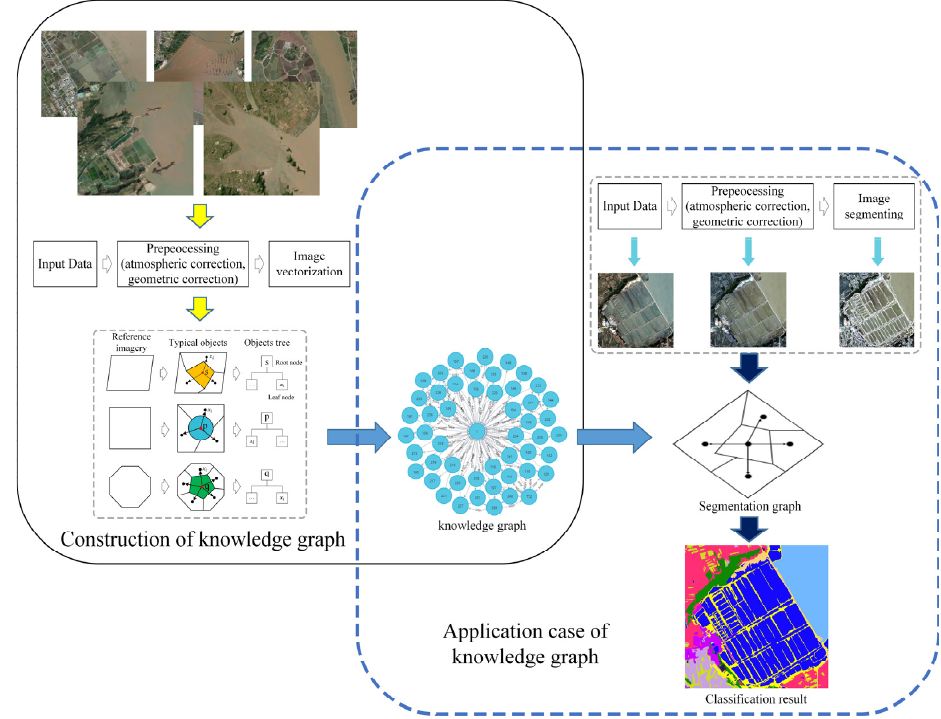
Figure 1. Systematic process of the proposed method. s, p, and q represent the oversegmented objects, while x i symbolizes the neighbors of the oversegmented